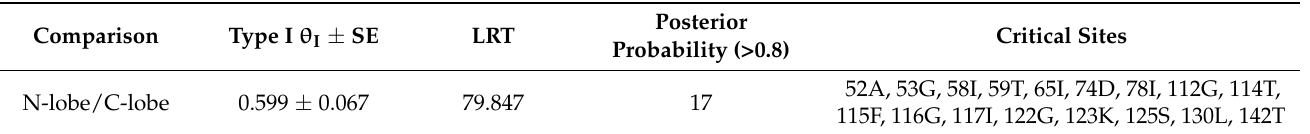
Table 2. Type I functional divergence between the N-lobe and the C-lobe of fish transferrin gene family. The critical sites are displayed by residues on the N-lobe.